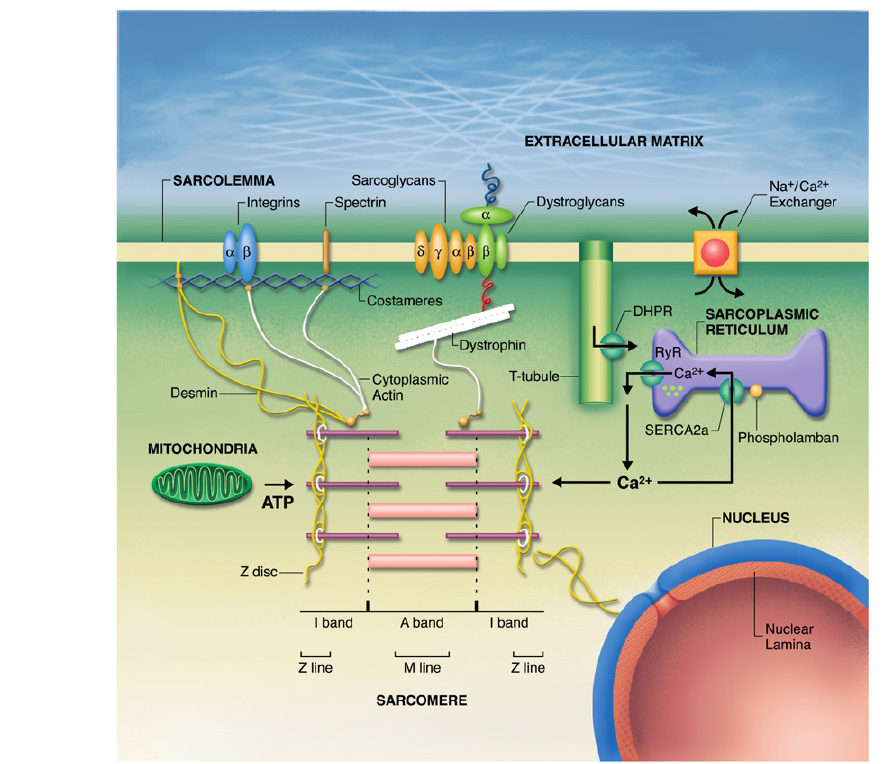
Figure 2. Subcellular organization of the cardiomyocyte. Disease genes for familial DCM encode protein components of the sarcomere, cytoskeleton, sarcolemma, nucleus, and sarcoplasmic reticulum. Fatkin, Physiological Reviews 2002, Am Physiol Soc, used with